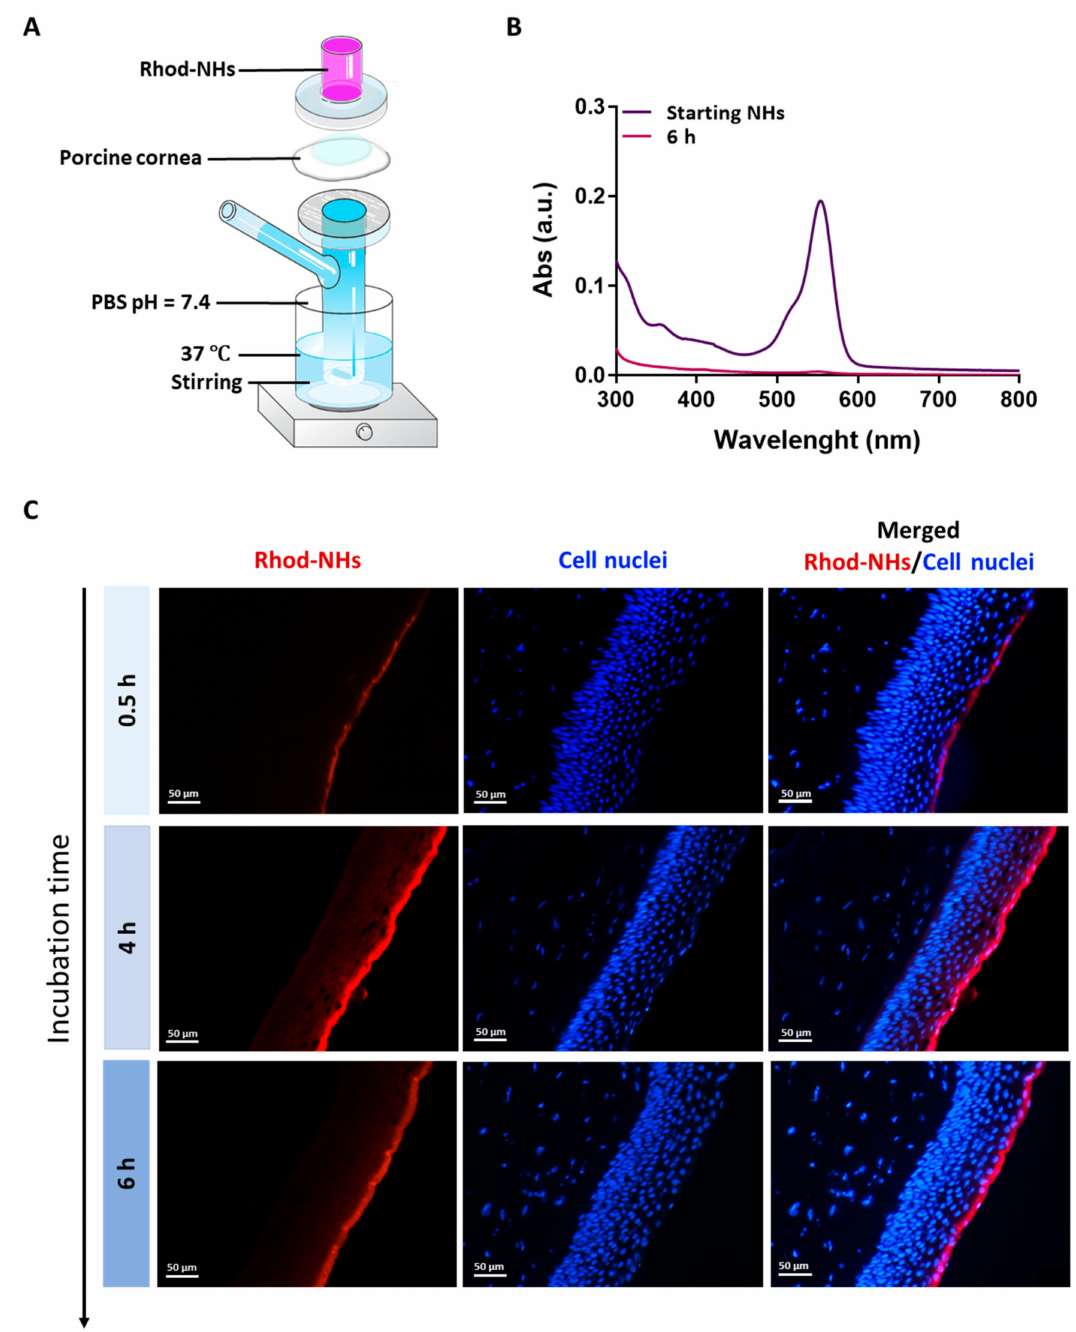
Figure 1. Experimental set-up used for the ex vivo transcorneal permeation experiments ( A ). UV absorbance of Rhod-NHs placed in the donor chamber of the Franz cell (dark purple line) and the solution in receiving chamber of Franz cell after 6 h of ex vivo transcorneal permeation experiment (purple line) ( B ). Fluorescence micrographs (scale bars: 50 µ m) of vertical slices of porcine corneas after 30 min, 4 h and 6 h of incubation with Rhod-NHs ( C